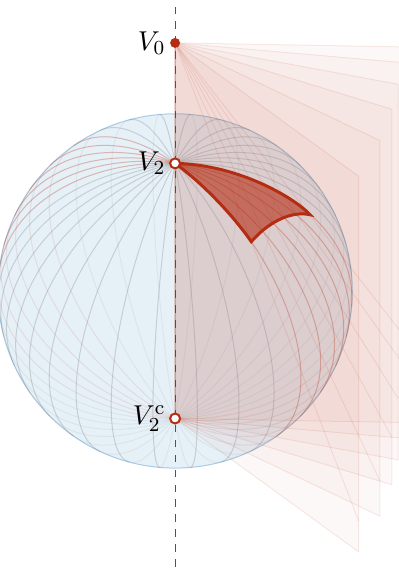
Figure 14 . Induced fibration of the quadric and of the generalized simplex. Each fibre of the quadric is induced from a CP 2 fibre in CP 4 intersecting the quadric. The original CP 4 is fibrated into dim- 2 planes through the line V . For better illustration the picture above is drawn with one 0 V 2 dimension